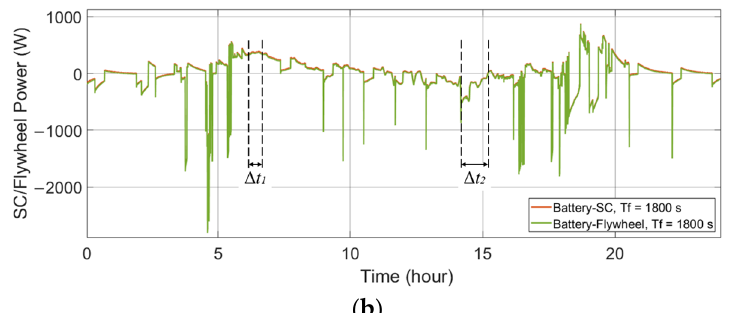
Figure 6. Power flows of the ESDs in the single-battery ESS and the HESSs applied to a PV-powered household-prosumer system. ( a ) Battery power. ( b ) SC/flywheel power.